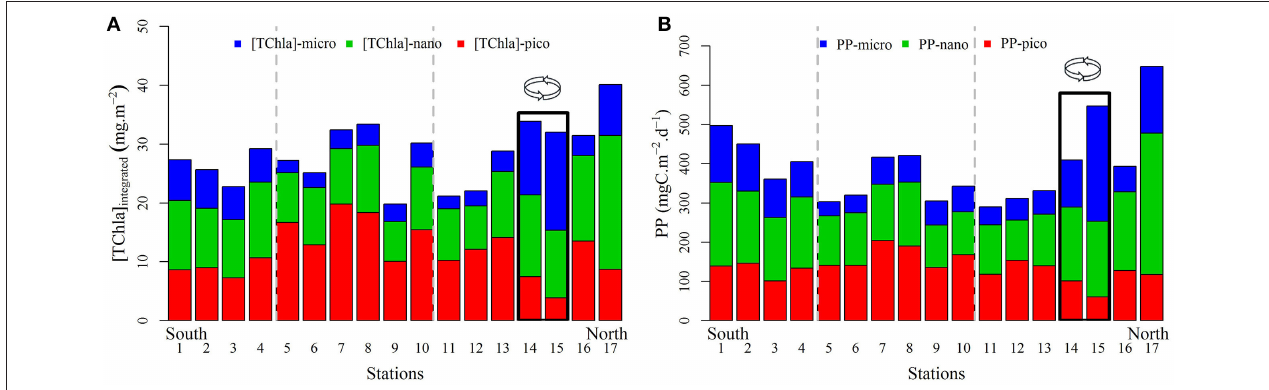
FIGURE 8 | Distribution of the 0–1.5 Ze integrated TChla contents (mg m − 2 ) (A) and primary production rates (mgC m − 2 d − 1 ) (B) associated to the three pigment-based size groups: pico- (red), nano- (green), and microphytoplankton (blue) for each station sampled along the transect. The stations within the eddy area are surrounded by a